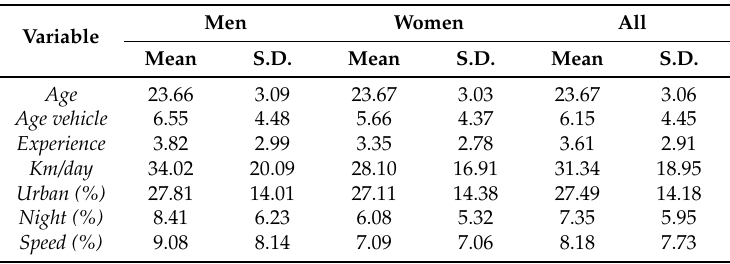
Table 2. Descriptive statistics for the age of the driver ( age ), the age of the vehicle ( age vehicle ), years of experience ( experience ), kilometers traveled per day ( km/day ), percentage of urban driving ( urban ), percentage of nighttime driving ( night ) and speed limit violations ( speed ).